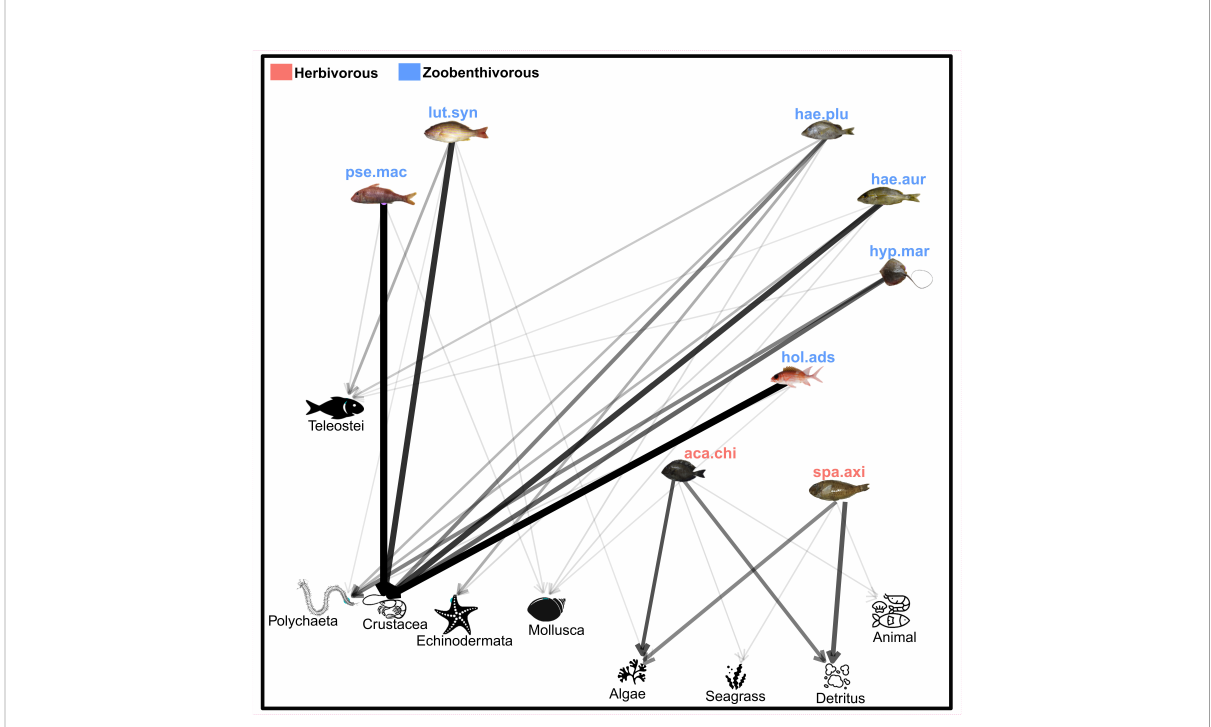
FIGURE 3 Network representing the main trophic compartments from which each selected species feeds. The thickness of the arrows corresponds to the importance of each item in the diet. lut.syn, Lutjanus synagris ; pse.mac, Pseudopenneus maculatus ; hae.plu, Haemulon plumierii; hae.aur, Haemulon aurolineatum ; hyp.mar, Hypanus marianae ; hol.ads, Holocentrus adscencionis ; aca.chi, Acanthurus chirurgus ; spa.axi, Sparisoma axillare